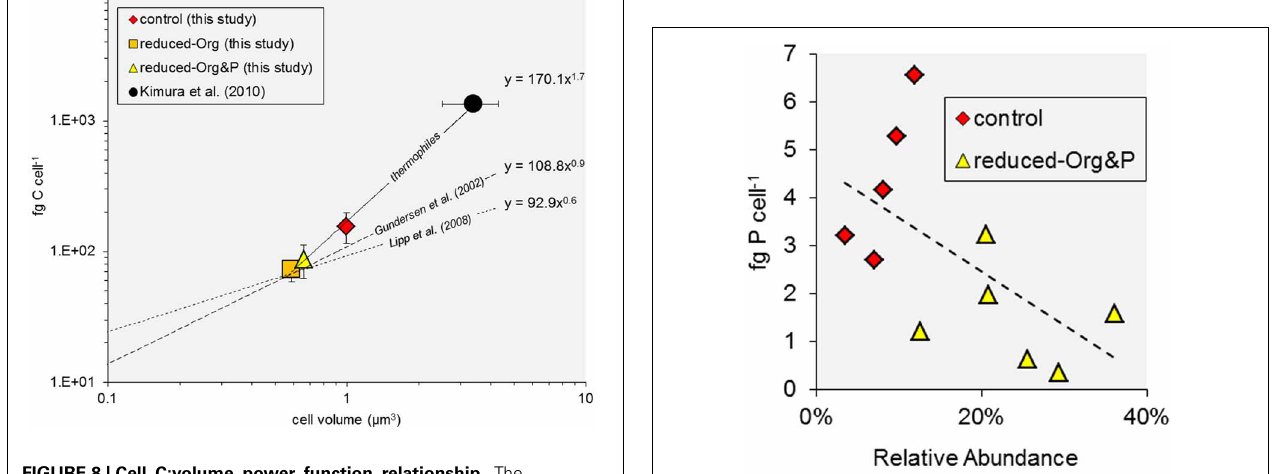
FIGURE 8 | Cell C:volume power function relationship. The relationship between measured and modeled values of cell C quota and volume are plotted for thermophiles (solid line), including data derived for T. kodakarensis (this study) and a thermophile community (Kimura et al., 2010), and compared to published data for bacteria and archaea (dashed lines; Gundersen et al., 2002; Lipp et al., 2008, after Simon and Azam, 1989).